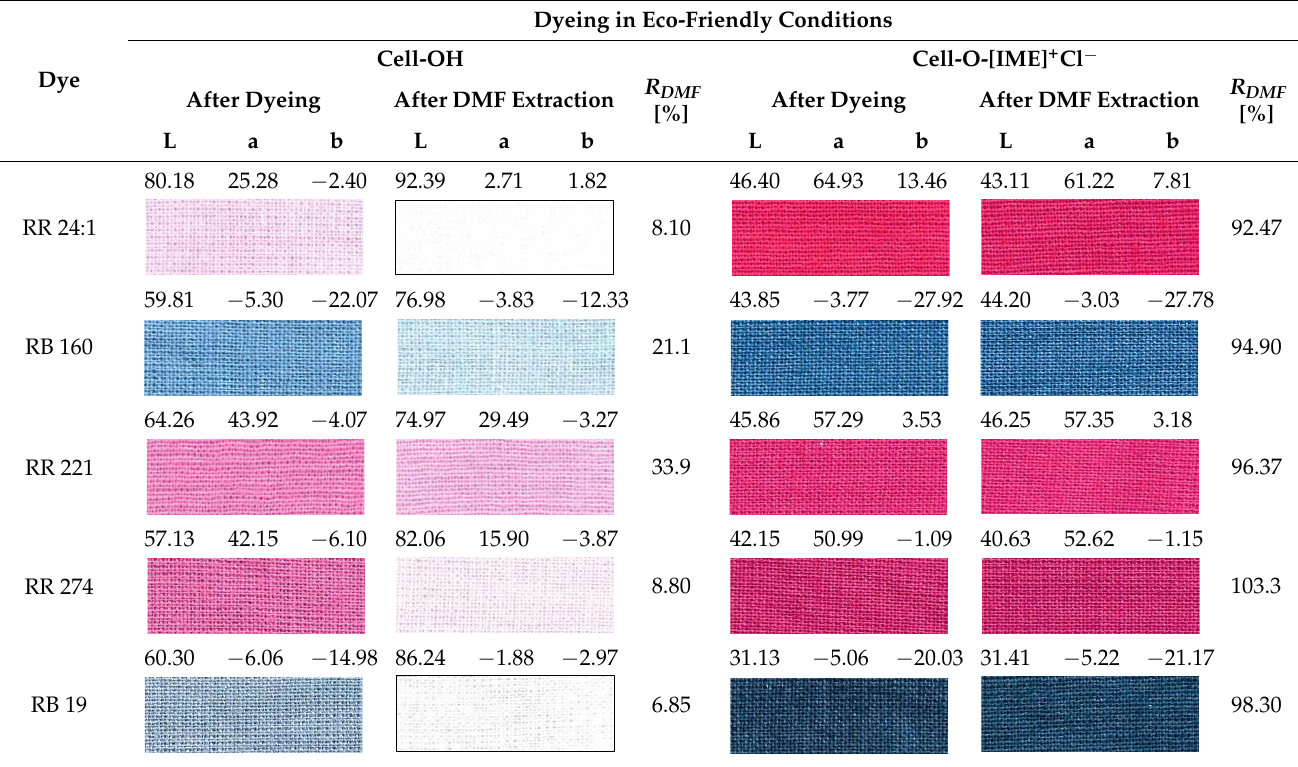
Table 5. Resistance data L a b and DMF extraction for dyed samples of [Cell-O-IME] + Cl − and Cell-OH.